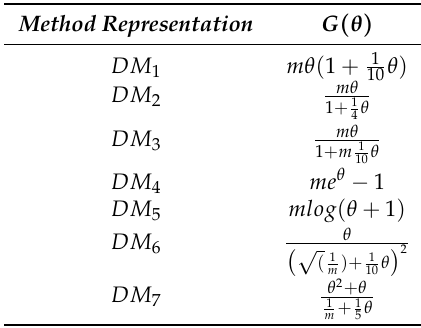
Table 1. The Kumar